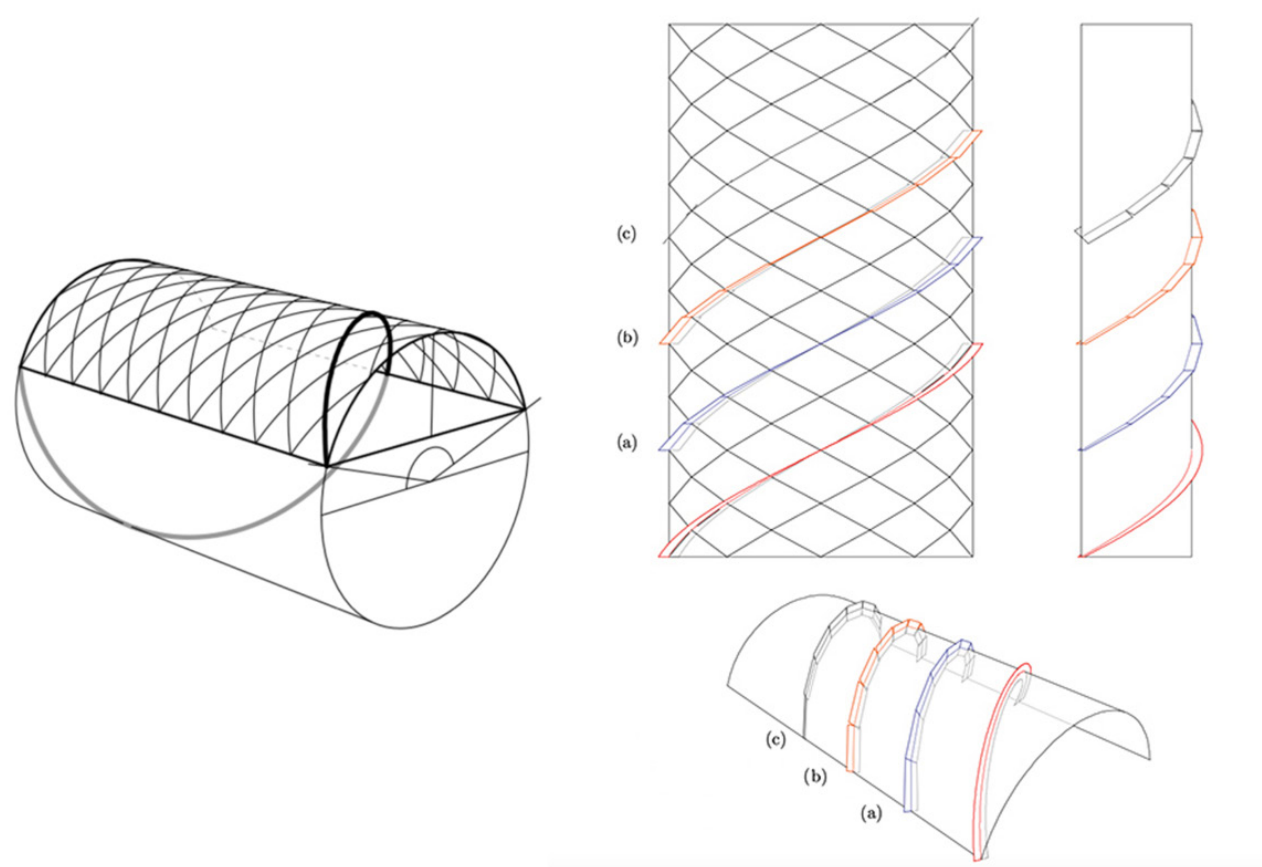
Figure 2. The geometry of the curve for equal distances between the lamellae; a helix on the circular cylinder surface ( left ). Three possible types of lamellae placement on a circular cylinder surface. Type ( a ) shows a continual torsion of the lamellae, type ( b ) are lamellae in discrete torsion, and type ( c ) are vertically placed lamellae. This drawing presents lamella, with the length of one diamond in the pattern ( right ) [4].